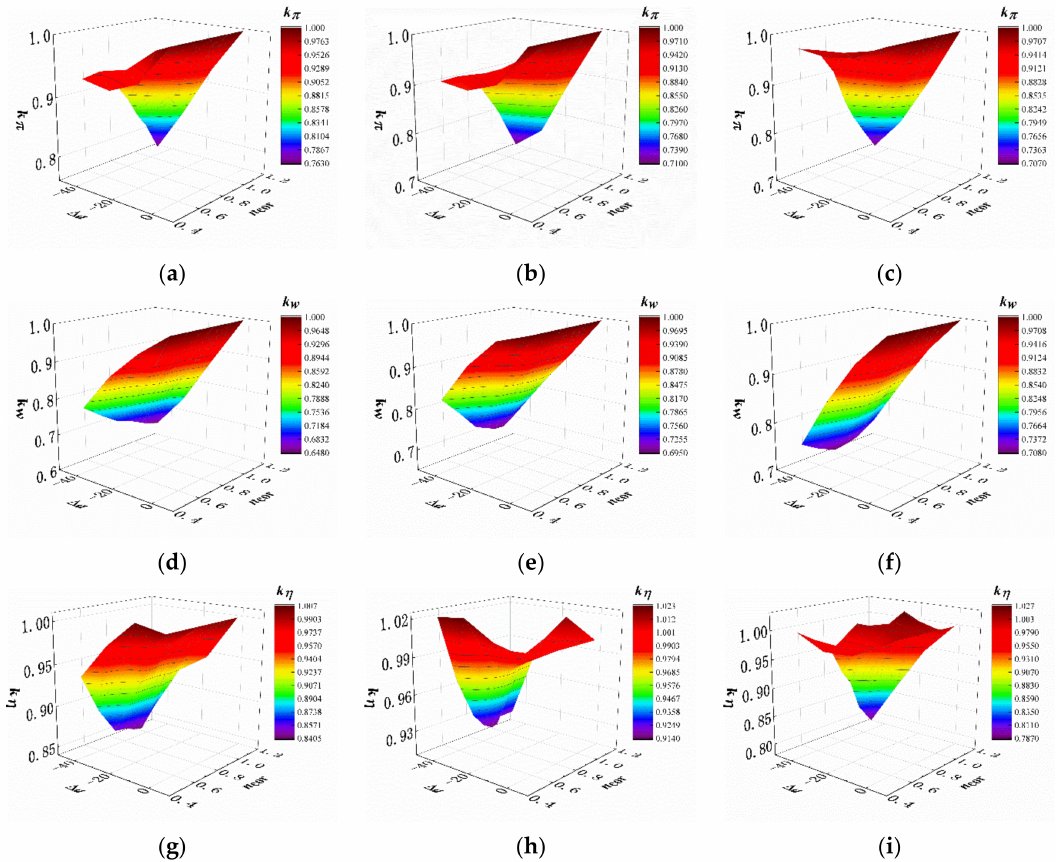
Figure 7. Surface diagram of change of offset coefficient at different operating points: ( a ) k π of the surge boundary point; ( b ) k π of the peak efficiency point; ( c ) k π of the stall boundary point; ( d ) k w of the surge boundary point; ( e ) k w of the peak efficiency point; ( f ) k w of the stall boundary point; ( g ) of the surge boundary point; ( h ) k η of the peak efficiency point; ( i ) k η of the stall boundary